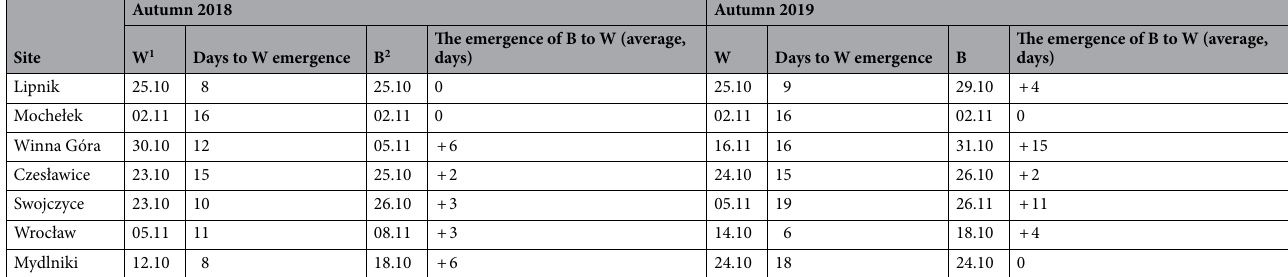
Y2 (Fig. 7D). At sites Czesławice, Wrocław and Mydlniki, according to the heavy soil, the W yield parameters were significantly higher than those at other sites, e.g., Lipnik, Mochełek, Swojczyce and Winna Góra, despite the uniform hydrothermal conditions in 2019/20 (Table 4).